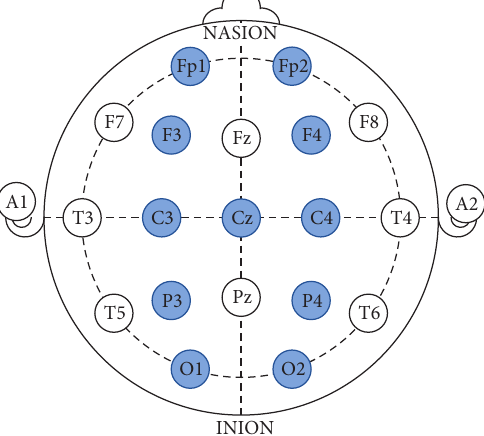
Figure 1: The International 10–20 System [33] with the 11 selected channels (in